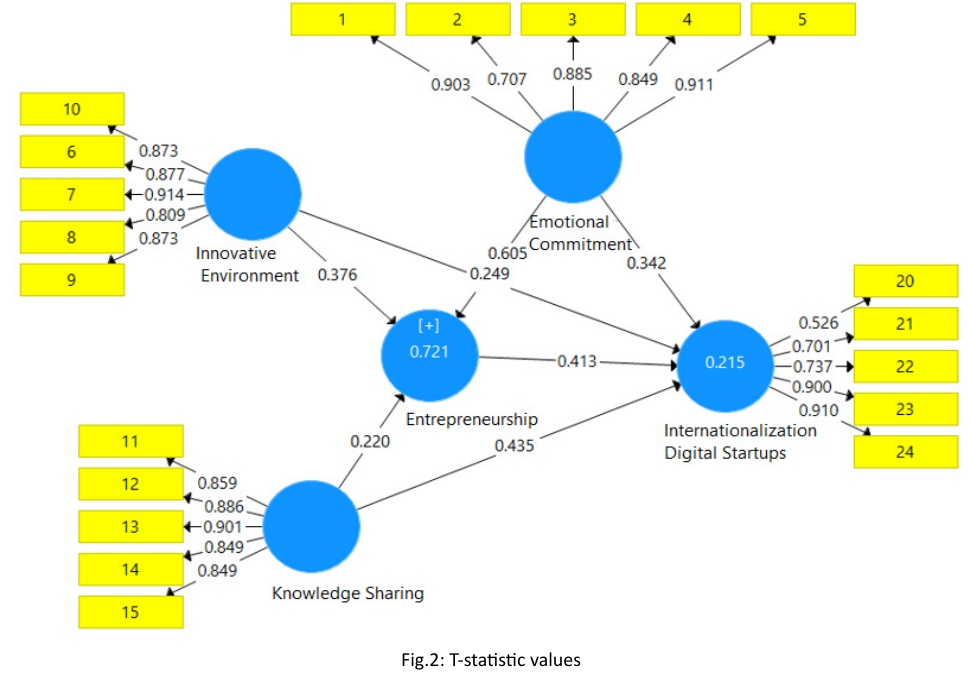
Fig.2: T‐statistic values Fig.2: T-statistic values